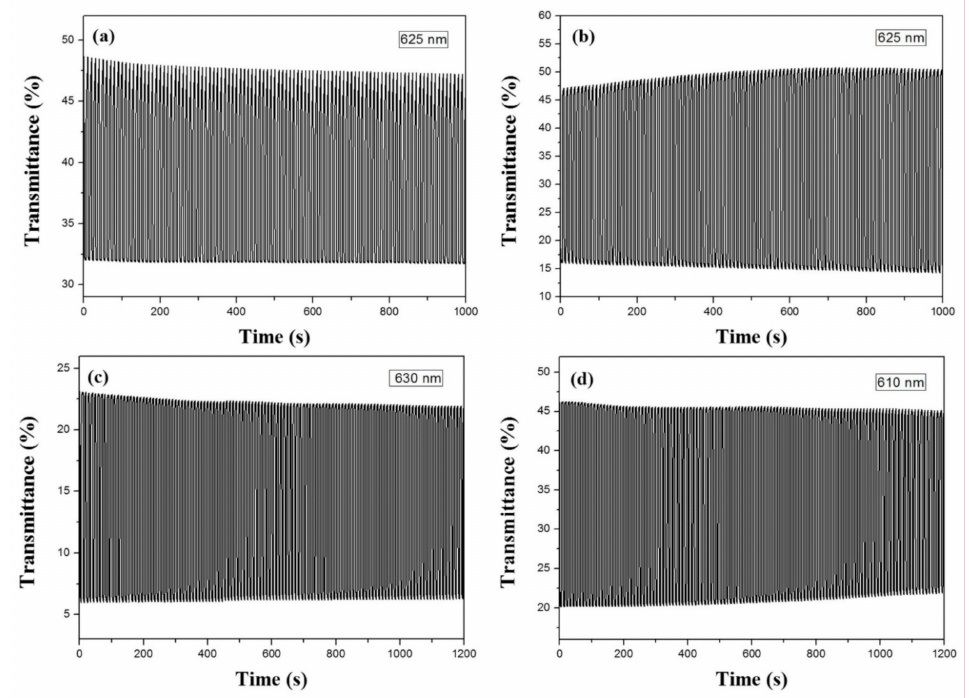
Figure 11. Optical contrast of ( a ) PBPBC/PEDOT, ( b ) P(BPBC- co -BT)/PEDOT, ( c ) P(BPBC- co -